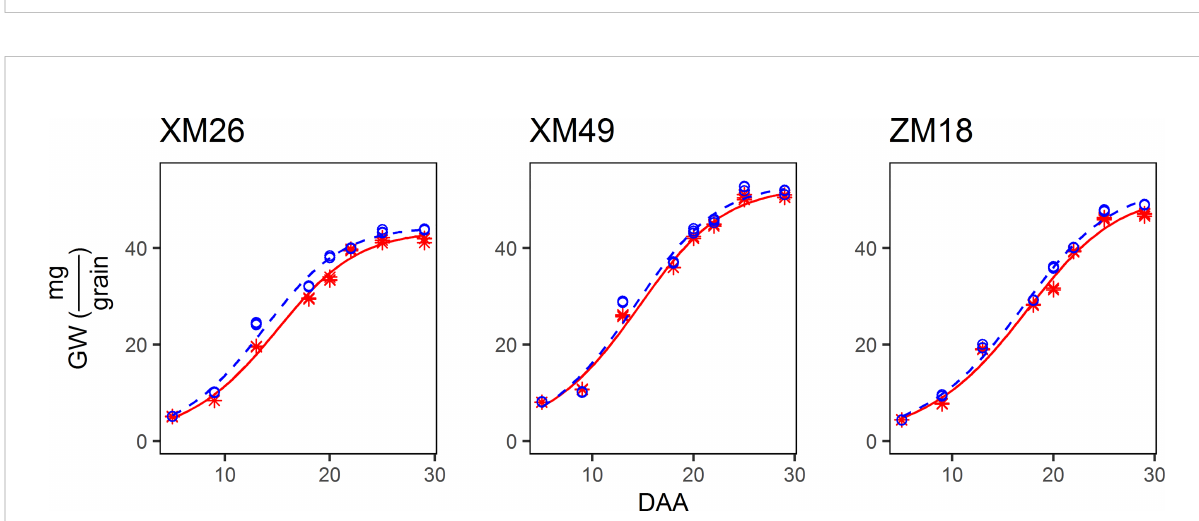
FIGURE 4 Dynamics of the grain weight (GW) of different genotypes of winter wheat under different levels of irrigation. Red lines indicate high-water treatment, blue lines indicate low-water treatment, red stars represent high-water treatment observations, and blue circles represent low-water treatment observations. DAA, days after anthesis; XM26, Xinmai-26; XM49, Xinmai-49; ZM18, Zhoumai-18.